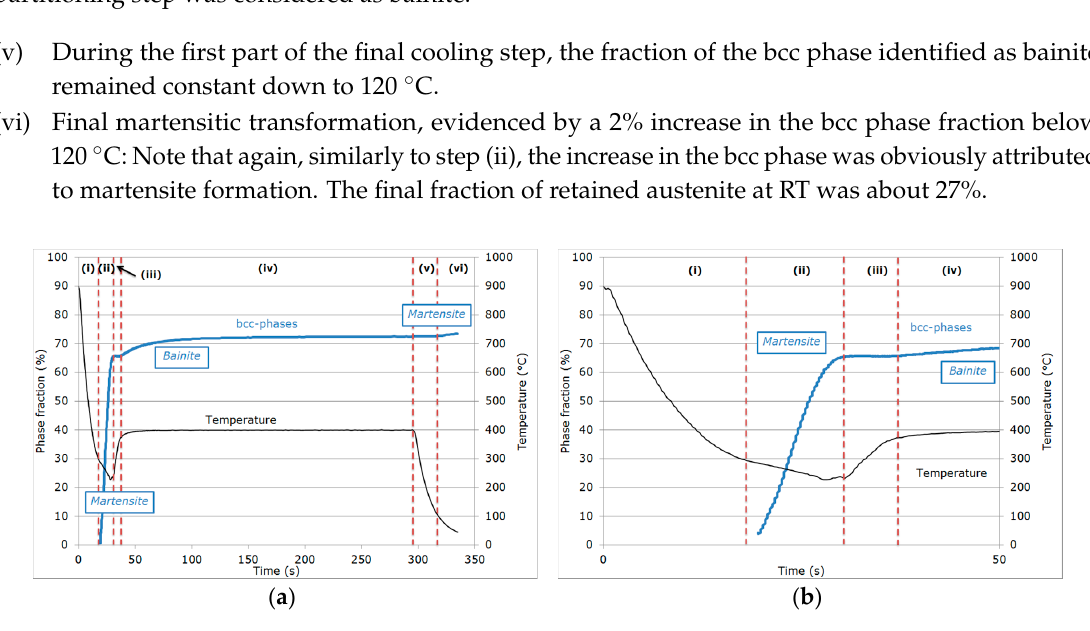
Figure 3. ( a ) Evolution of phase fractions and temperature as a function of time measured along the reference cycle: QT = 230 °C/PT = 400 °C. ( b ) Focus is on the first 50 s, covering the first four steps detailed in the text. As discussed in [23], the maximum error made on fraction measurements was about ±1%.